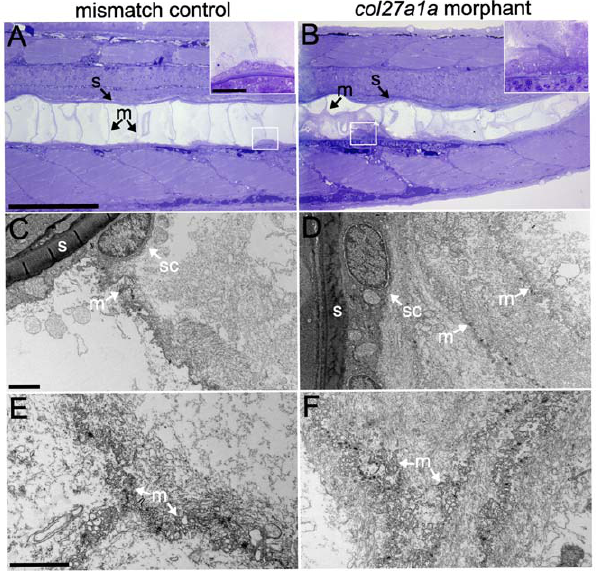
Figure 6. Protein and cellular accumulation in the col27a1a morphant notochord. Semithin sections (300 nm) of mismatch control (A) and col27a1a morphant (B) notochord were stained with Richardson’s stain for proteins at , 4.5 SSL (10 dpf). The morphant notochord showed abnormal cellular clumping along the notochord sheath (white box and inset) and increased staining along membranes between notochord cells. (C–F) TEM analysis indicated that this staining was due to increased protein accumulation along membranes separating notochord cells. Scale bar in A represents 200 m m and applies to B. Scale bar in A inset represents 20 m m and applies to B inset. Scale bars in C and E represent 2 m m and apply to D and F, respectively. s, notochord sheath; sc, sheath cell; m, membrane.